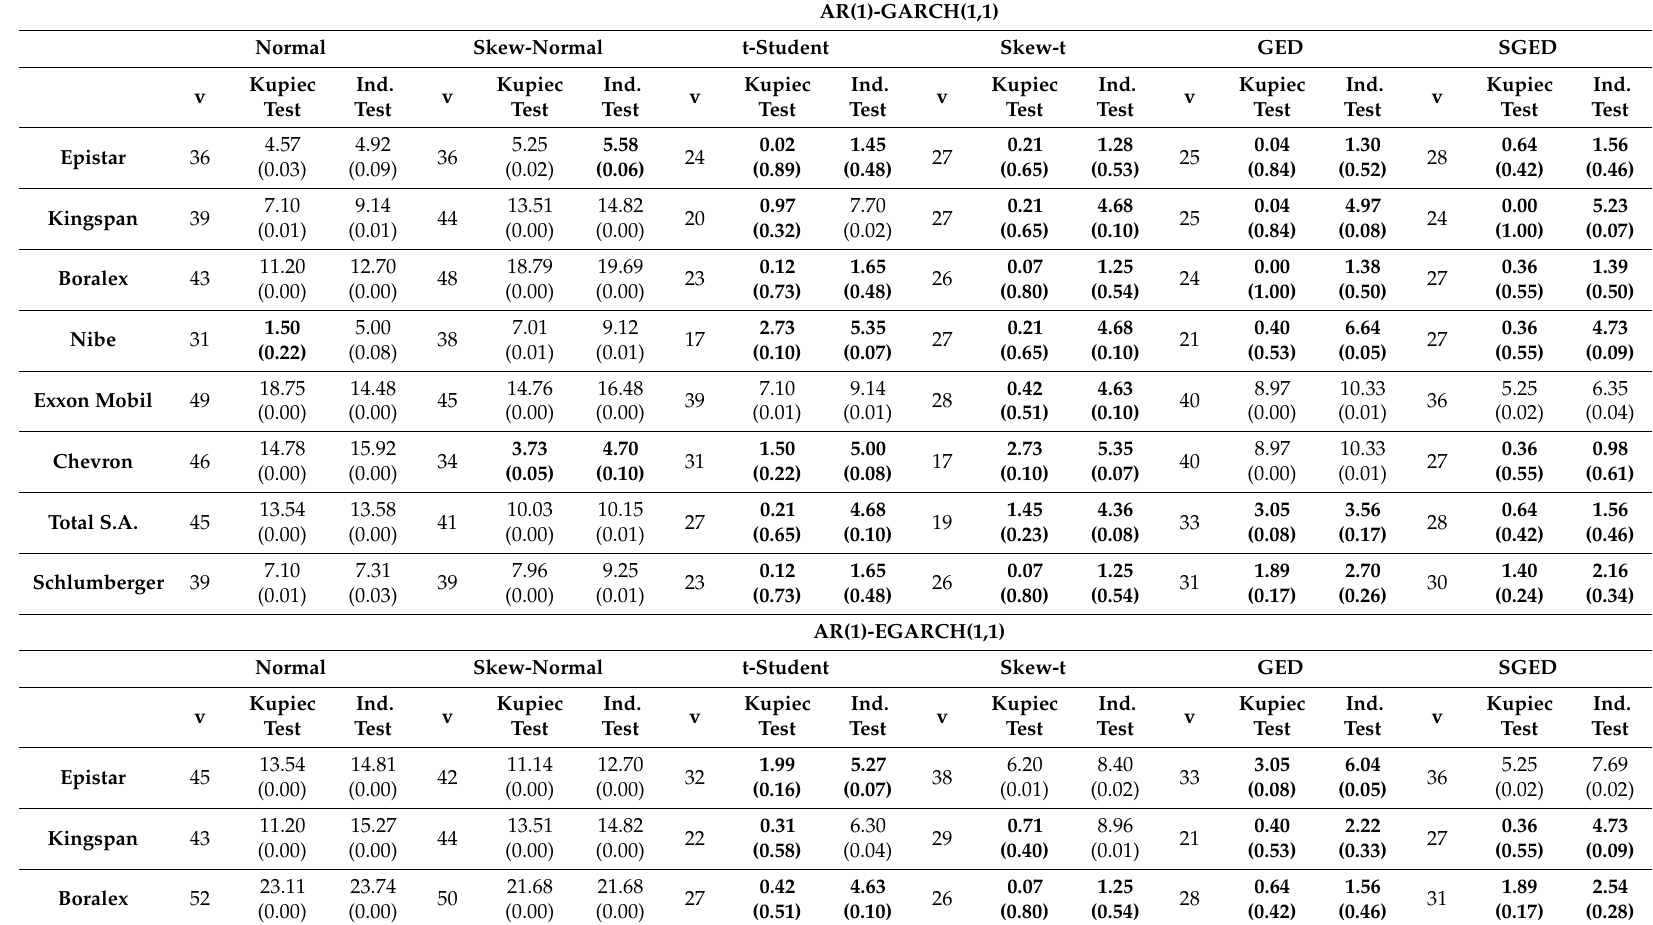
Table 3. 99%-VaR backtesting. Expected violations (EV) =